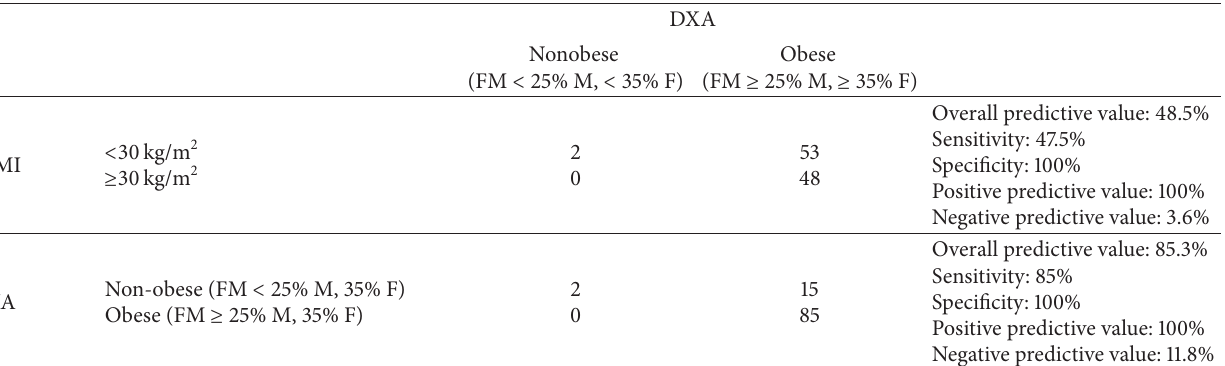
Table 2: Predictive value of BIA and BMI towards